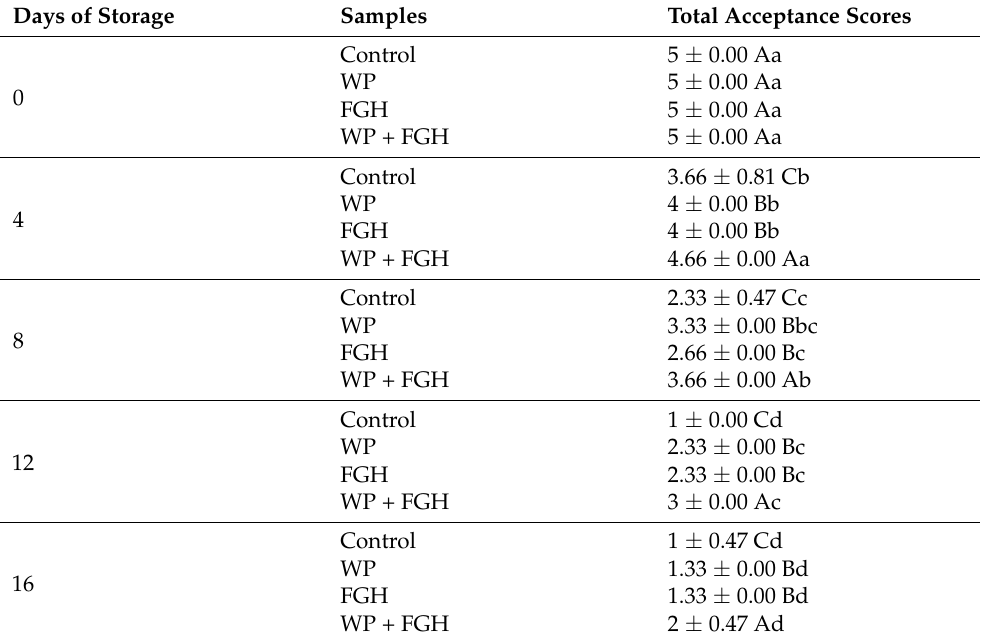
Table 2. Total acceptance scores of chicken breasts fillets coated with whey protein (WP), fish gelatin hydrolysates (FGH), or a combination of both (WP + FGH) during cold storage at 4 ◦ C. Total acceptance points were considered in a range of 5 (strong like) to 1 (strong dislike). Score of 3 was considered as the limit of